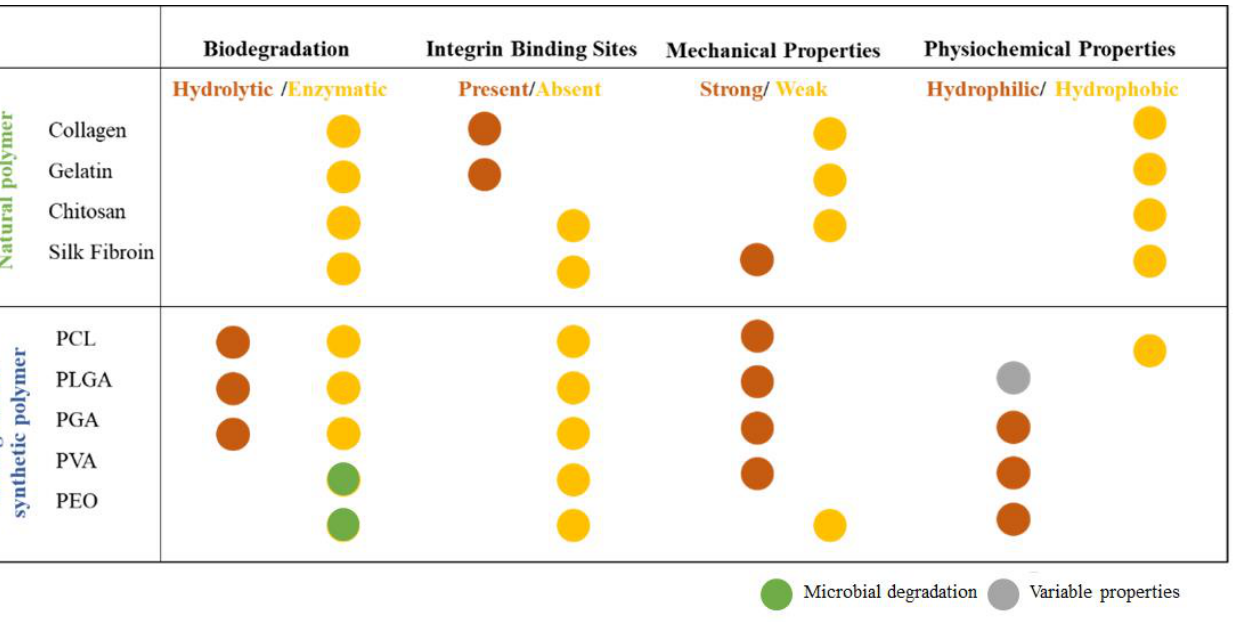
Figure 3. Physicochemical, mechanical, and biological properties of natural and synthetic polymers for nanofiber fabrication.